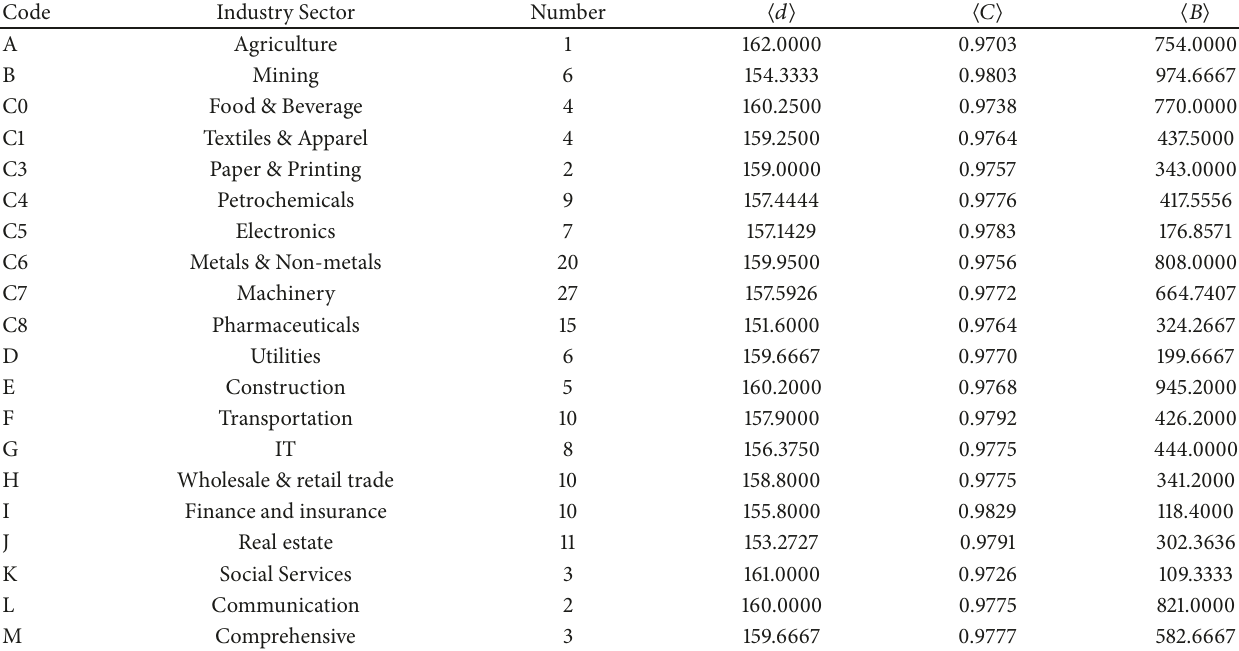
Table 6: In this table, we list the China Securities Regulatory Commission (CSRC) industry code, the sector name and the numbersof stocks, the average degree ⟨𝑑⟩ , the average clustering coefficient ⟨𝐶⟩ , and the average betweenness coefficient ⟨𝐵⟩ for each industry sector of these 163 stocks. The values are calculated from the CSI163 network with 𝜃 = 1.0